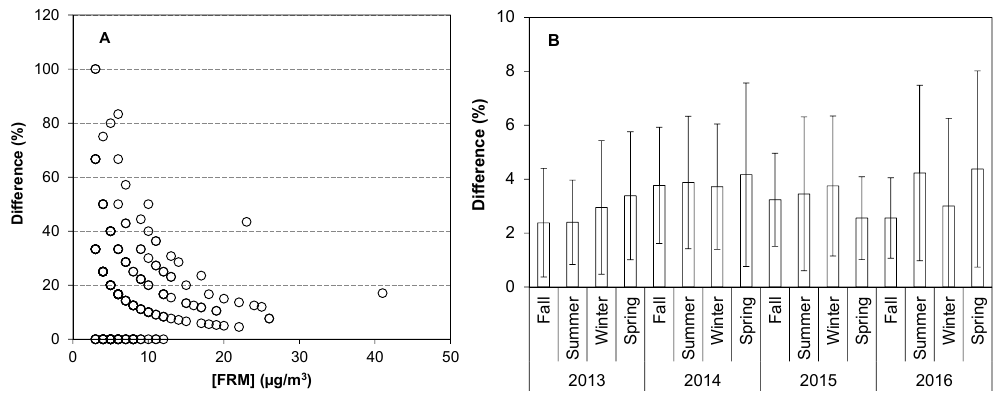
Figure 4. Difference percentages between the SHARP 5030 and the FRM concentrations vs FRM concentrations at the Toronto West station ( A ) and difference percentages in different seasons ( B ).